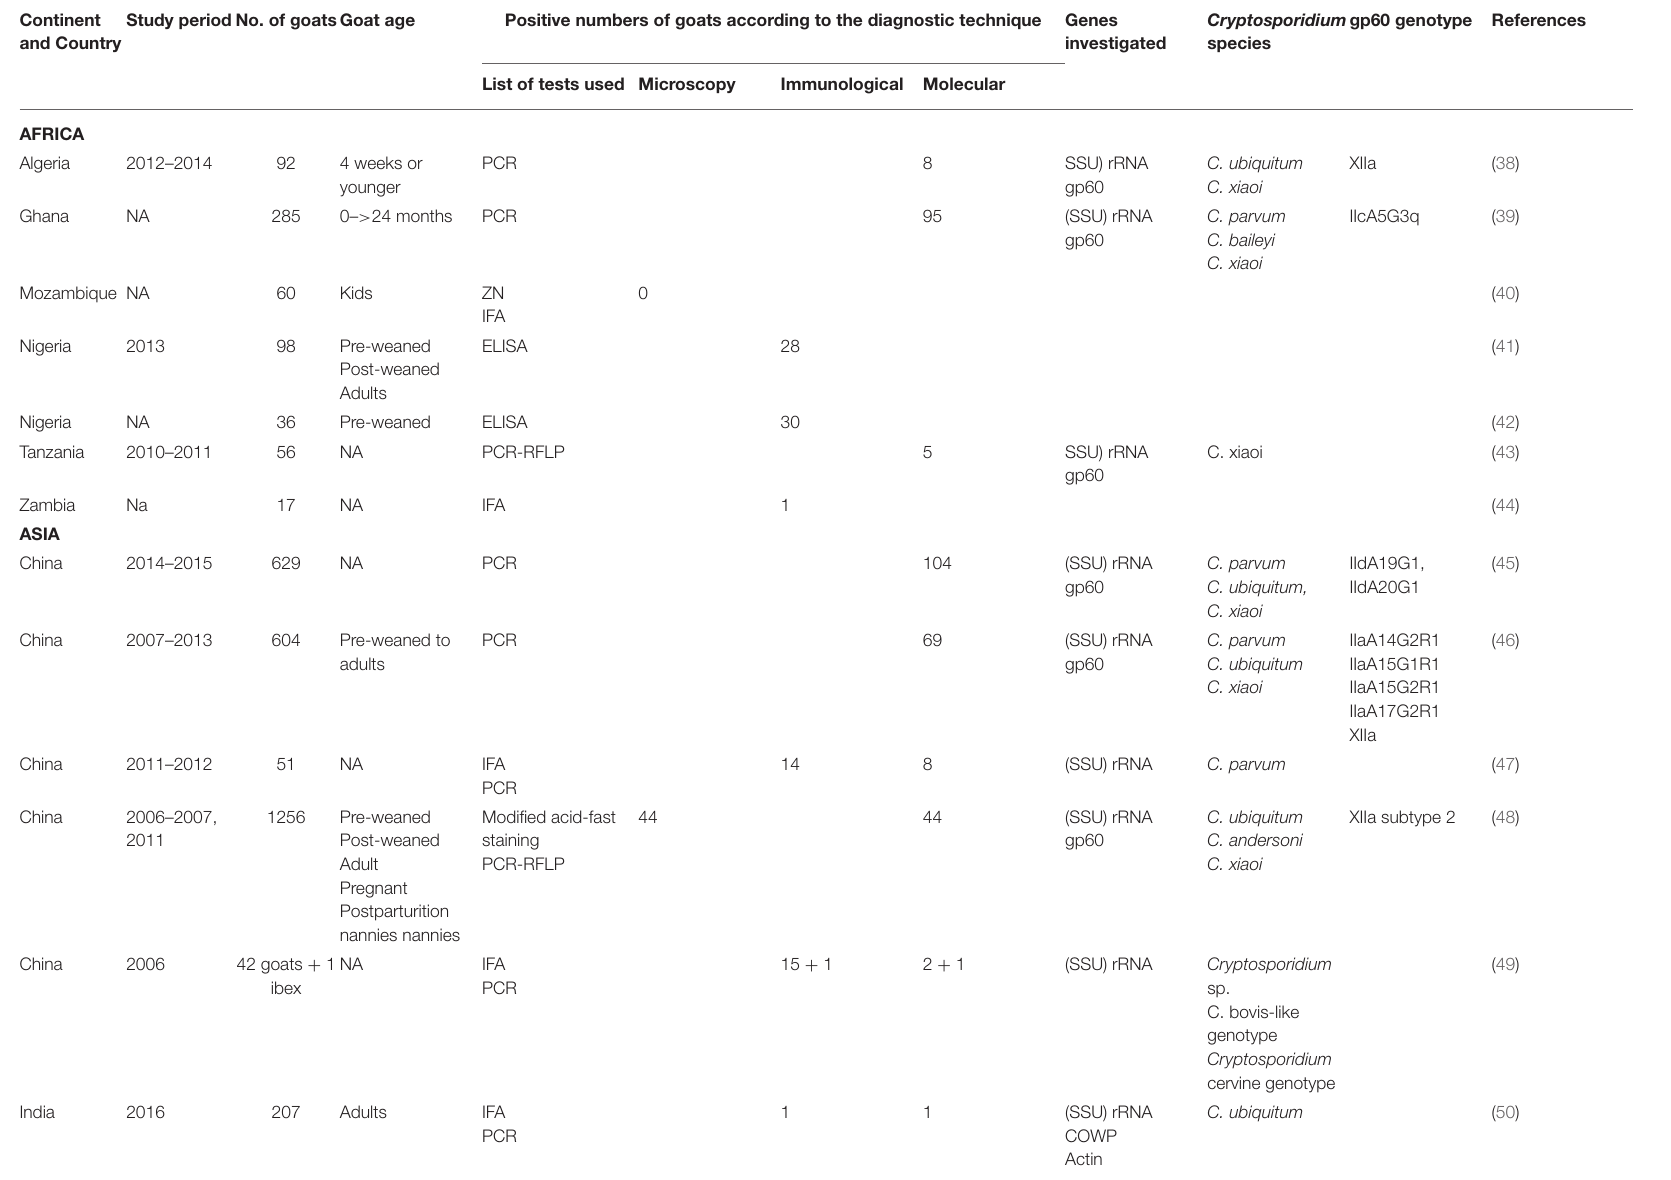
TABLE 1 | Studies investigating Cryptosporidium in goats. Occurrence of Cryptosporidium spp. in goats worldwide using different diagnostic techniques Species and subtypes of Cryptosporidium in goats worldwide Continent Study periodNo. of goatsGoat age Positive numbers of goats according to the diagnostic technique Genes and Country